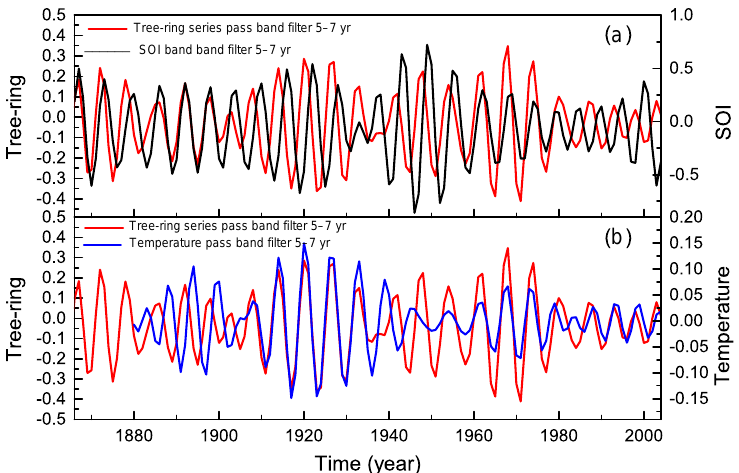
Figure 9. (a) Signals filtered of the mean width of tree-ring series and annual mean temperature anomaly (from 24 to 44 ◦ S); (b) annual mean temperature anomaly (from 24 to 44 ◦ S) and sunspot number, between 5 and 7